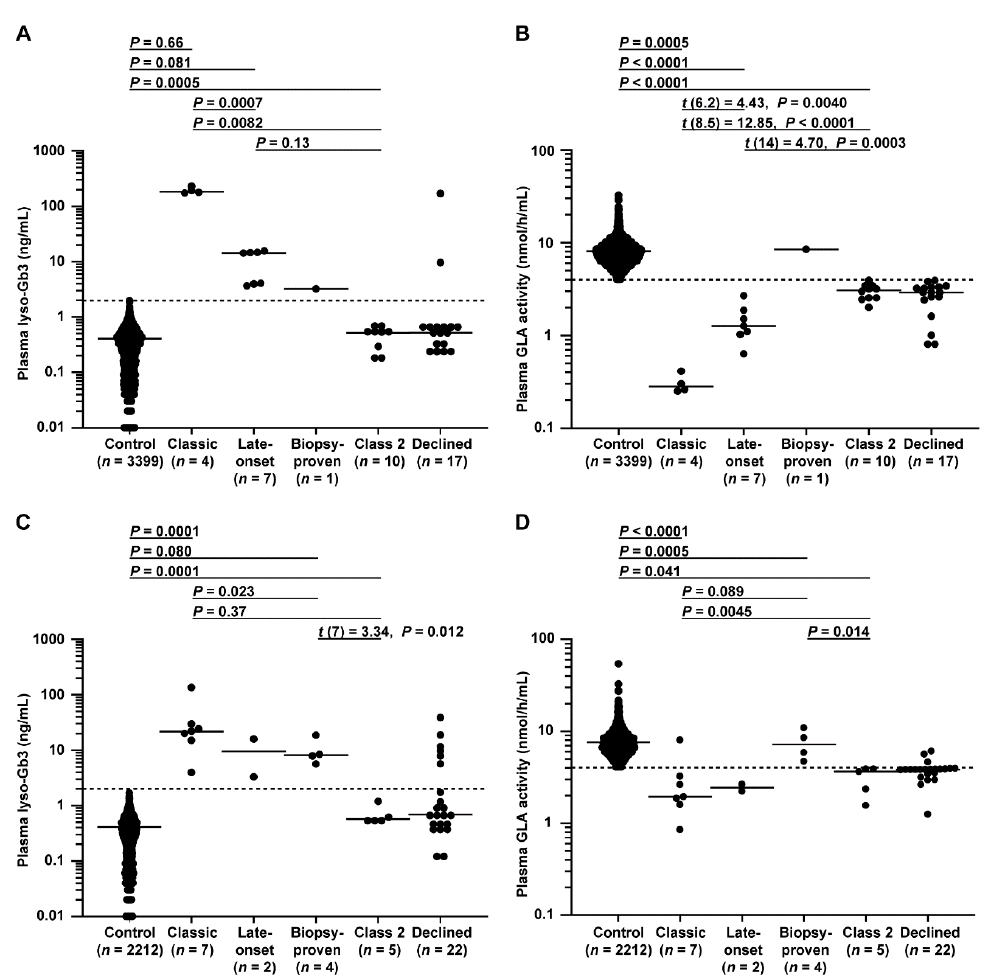
Figure 4. Plasma lyso-Gb3 levels and GLA activity in male and female patients. ( A , B ) Male patients enrolled between 1 July 2014 and 31 December 2016 belonging to control, classic, late-onset, late-onset biopsy-proven, class 2, or declined groups; patients belonging to the late-onset biopsy-proven group, which was unsuitable for statistical analysis due to its small number, not detected group ( n = 1) summarized in flowcharts in Figure 2, and declined group, in which GLA variants were not analyzed, were excluded from the analysis. ( A ) The dotted line indicates the threshold for a positive test of 2.0 ng/mL. Short horizontal lines indicate the median plasma lyso-Gb3 value in each group. When plasma lyso-Gb3 values were less than the detection limit of the assay (0.01 ng/mL), a value of 0 ng/mL was used to represent the lyso-Gb3 levels in the statistical analysis. Patients with a lyso-Gb3 value of 0 ( n =156 males in the control and n = 1 male in the class 2 group in A ) could not be plotted on a logarithmic graph. ( B ) The dotted line indicates the threshold of 4.0 nmol/h/mL for a positive test. Short horizontal lines indicate the median plasma GLA activity in each group. Plasma GLA activities were detected in all patients. Differences between groups were evaluated with the Student’s t -test, Welch’s t -test, or Wilcoxon rank-sum test; data are shown as t (integral degree of freedom) = t value and P value (Student’s t -test); t (mixed decimal degree of freedom) = t value and P value (Welch’s t -test); or P value only (Wilcoxon rank-sum test). ( C , D ) Female patients enrolled between July 1 2014 and 31 December 2016 belonging to control, classic, late-onset, late-onset biopsy-proven, class 2, or declined groups; patients belonging to the late-onset group, which was unsuitable for statistical analysis due to its small number, and declined group, in which GLA variants were not analyzed, were excluded from the analysis. ( C ) The dotted line is the threshold for a positive test of 2.0 ng/mL. Short horizontal lines indicate the median plasma lyso-Gb3 value in each group. When plasma lyso-Gb3 values were less than the detection limit of the assay (0.01 ng/mL), a value of 0 ng/mL was used to represent the lyso-Gb3 levels in the statistical analysis. Patients with a lyso-Gb3 value of 0 ( n = 123 in the control in C ) could not be plotted on a logarithmic graph. ( D ) The dotted line indicates the threshold of 4.0 nmol/h/mL. Short horizontal lines indicate the median plasma GLA activity in each group. Plasma GLA activities were detected in all patients. Differences between groups were evaluated with Student’s t -test or the Wilcoxon rank-sum test; data are shown as t (integral degree of freedom) = t value and P value (Student’s t -test) or P value only (Wilcoxon rank-sum